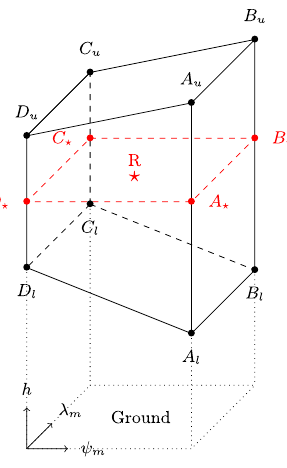
Figure A1. Location of the eight neighbors of a radar gate R . The position of the radar gate is shown by a red